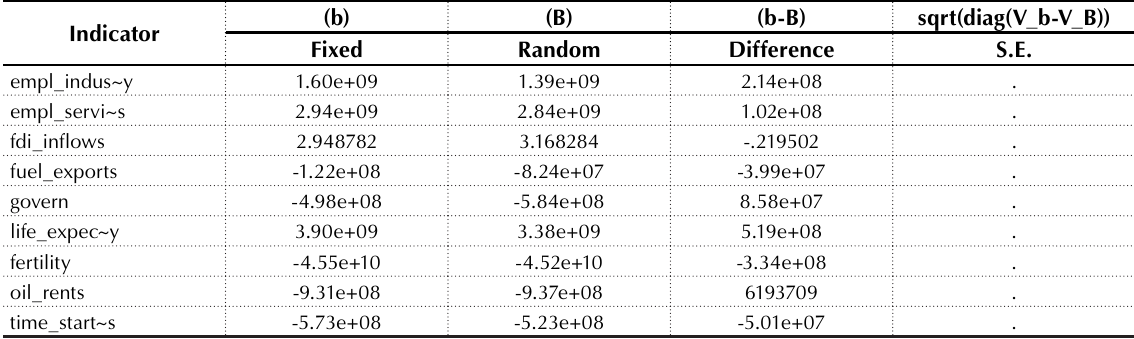
Table 1. The results of the Hausman test for the studied